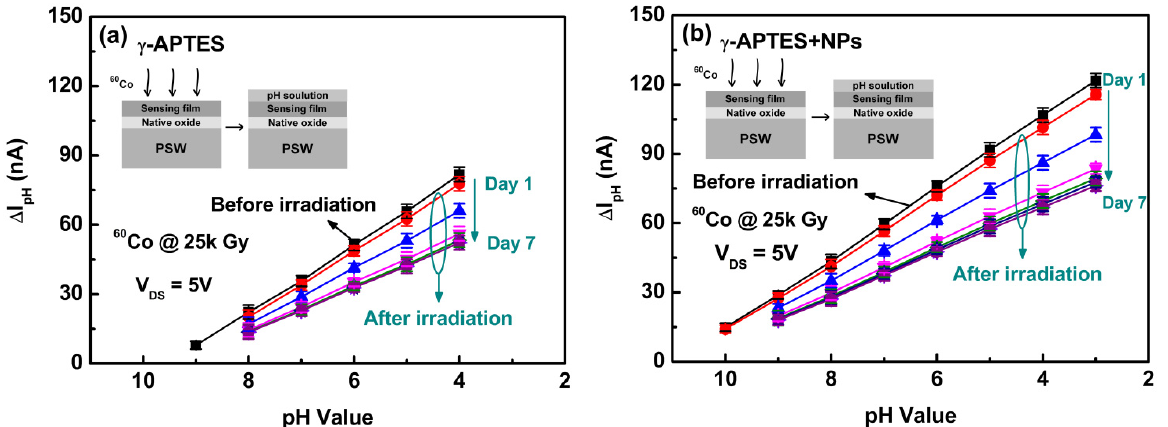
as a function of pH value over pH